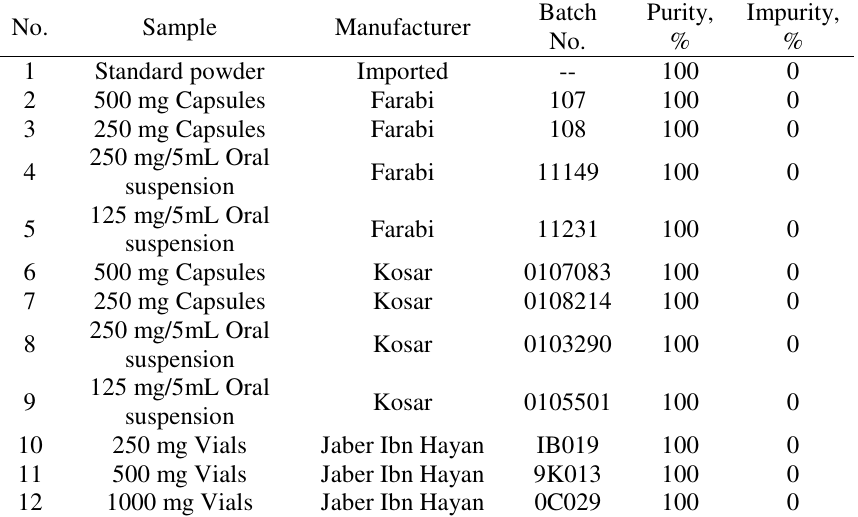
Table 2 . Comparison of purity of ampicillin products by HPLC method